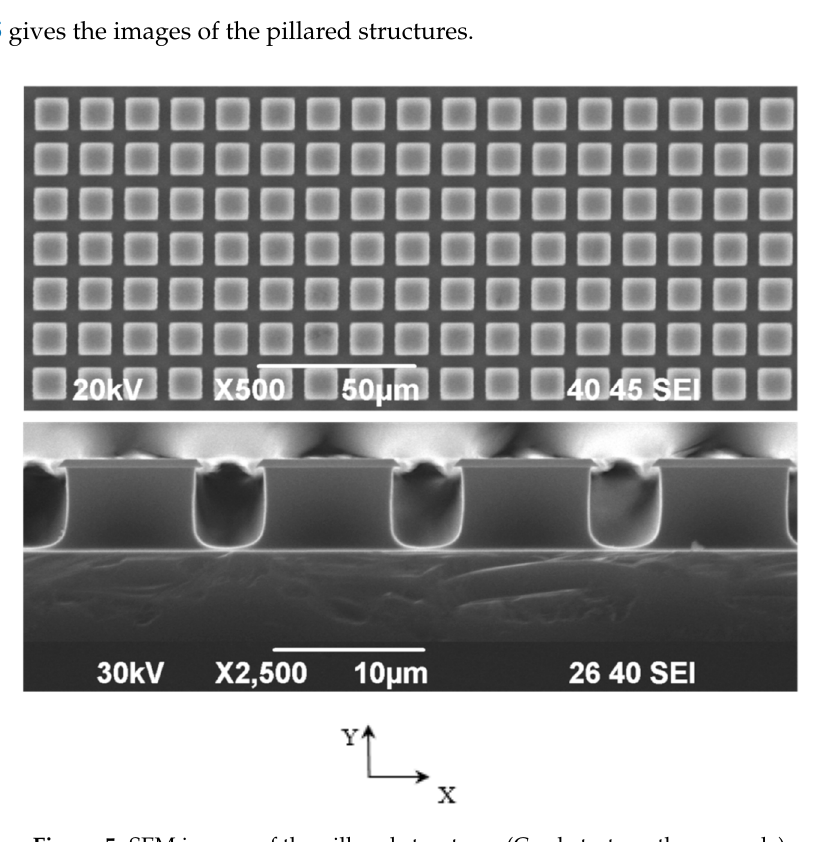
Figure 5. SEM images of the pillared structures (C substrate as the example).